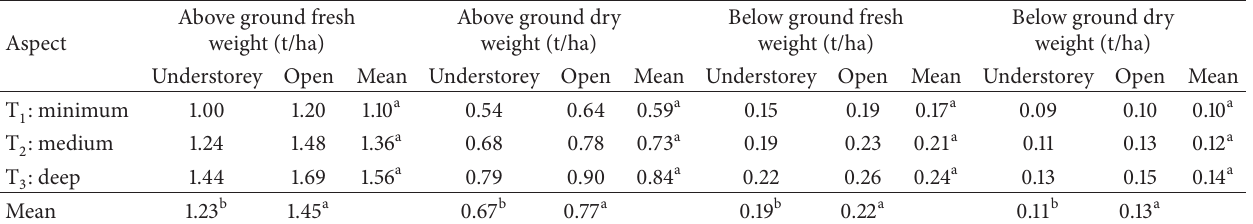
Table 5: Effect of tillage practices on biomass and yield (t/ha) of Andrographis paniculata in understorey and open conditions. Above ground fresh Above ground dry Below ground fresh Below ground dry Aspect weight (t/ha) weight (t/ha) weight (t/ha) weight (t/ha) Understorey Open Mean Understorey Open Mean Understorey Open Mean Understorey Open Mean